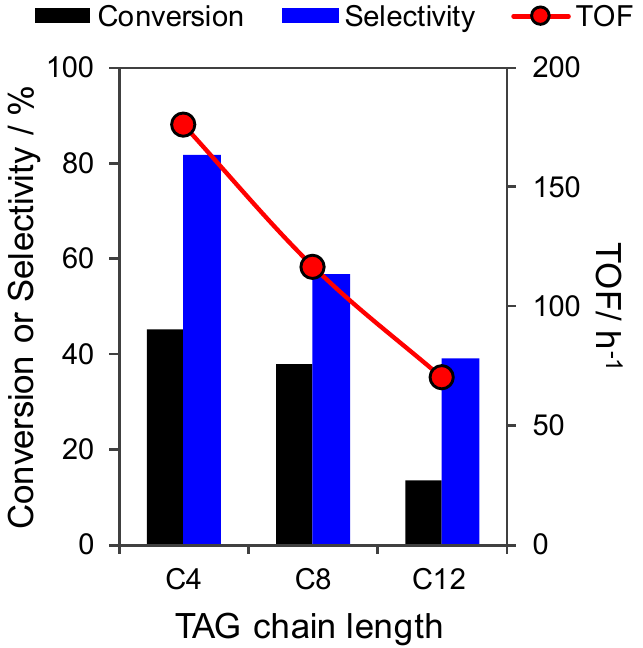
Figure 4. Catalytic performance of reconstructed Ni 4.1 Al LDH for transesterification of C 4 ‐ C 12 TAGs with methanol; conversion and selectivity values after 24 h, TOF calculated from initial rate over 1 h reaction. Reaction conditions: 100 mg catalyst, 110 °C, 10 mmol TAG, 30:1 methanol:TAG molar ratio (20 wt% 1 ‐ butanol for C 8 –C 12 TAG), 650 rpm stirring.